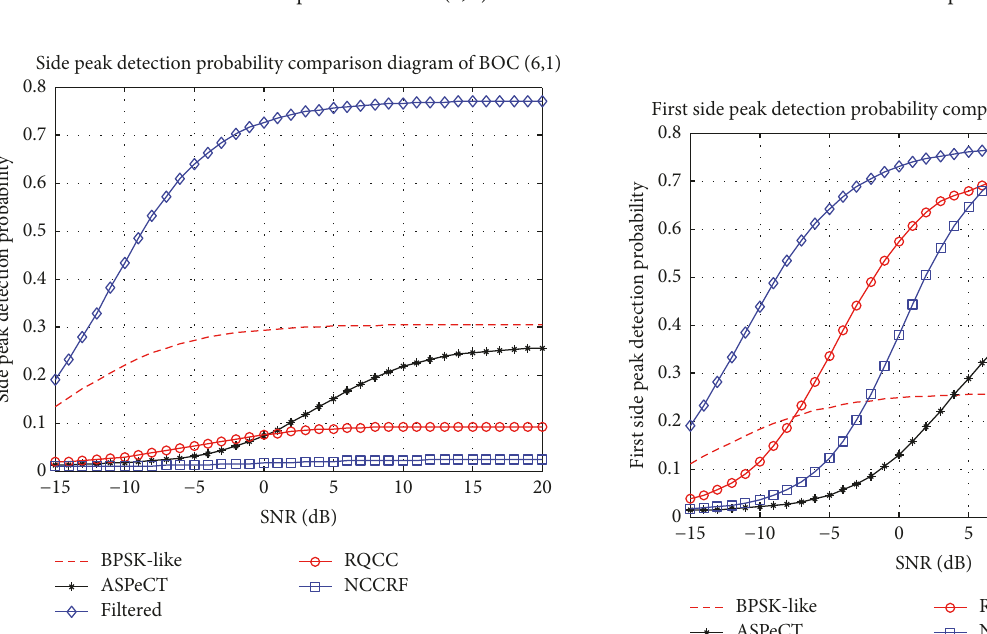
Figure 17: The SPDR comparison of BOC ( 8, 4 ).